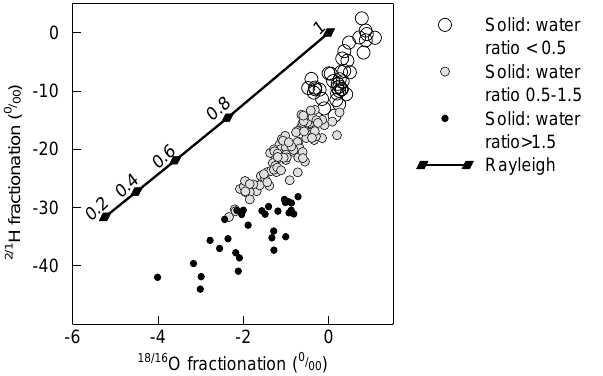
Figure 5. Apparent isotopic fractionation ( 2 / 1 H vs. 18 / 16 O) of ex- tracted water as observed in all experiments (markers indicate three groups of solid:water ratios) and fractionation as expected from Rayleigh fractionation (line; numbers denote the fraction of ex- tracted water).